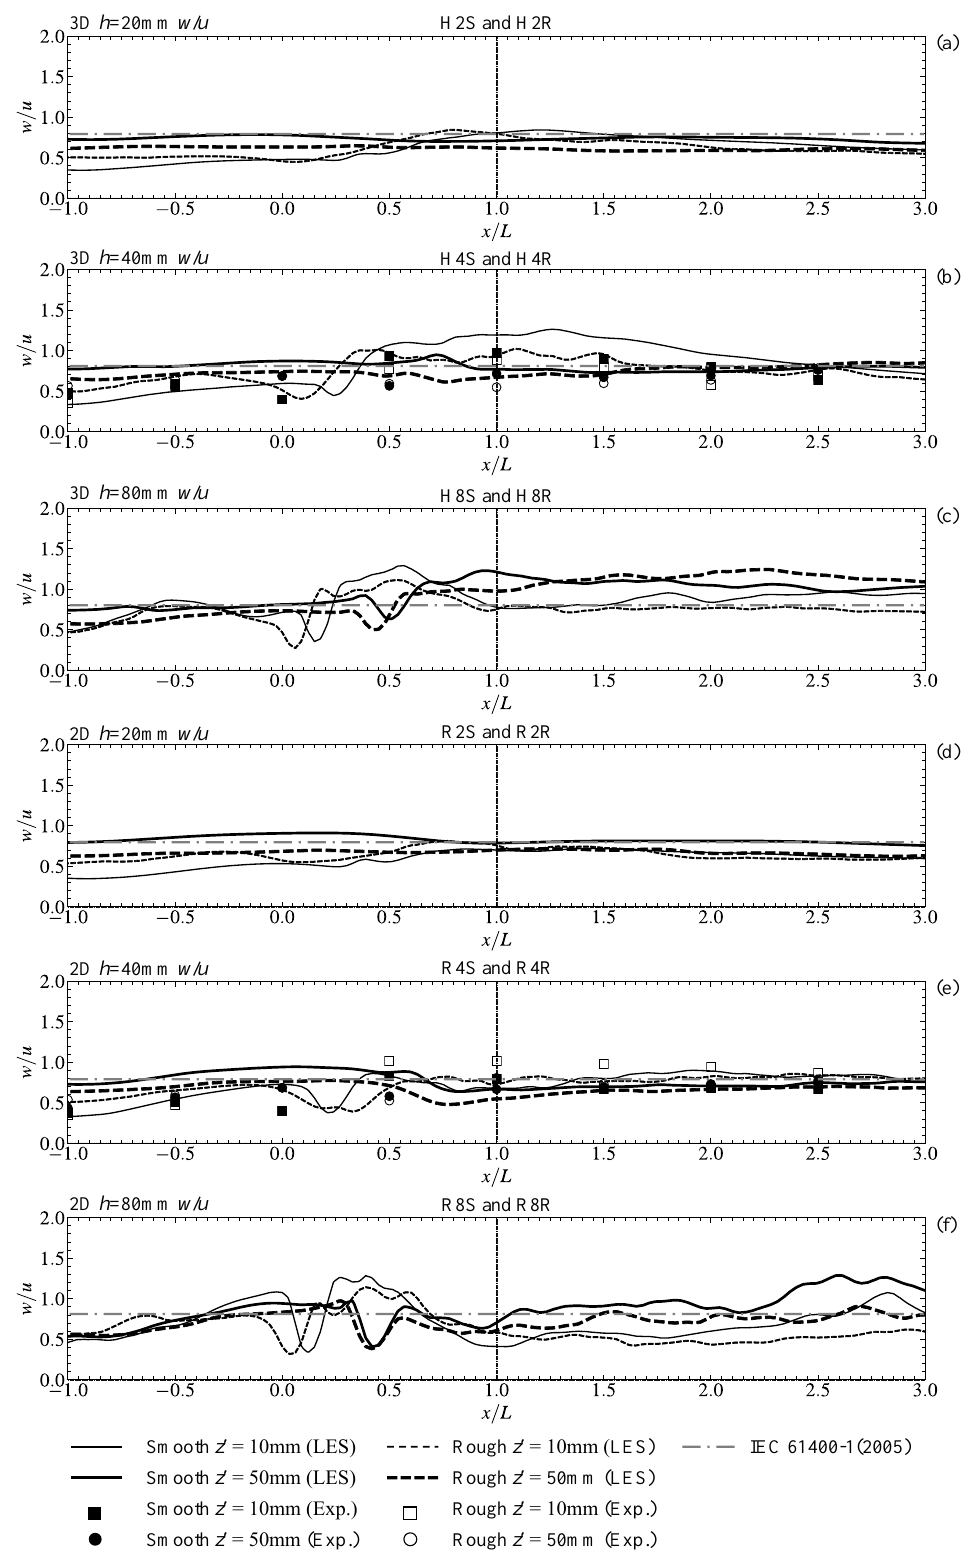
Figure 11. Fluctuation ratio w / u at z ′ = 10 mm and 50 mm, ( a ) 3D hills with h = 20 mm, ( b ) 3D hills with h = 40 mm, ( c ) 3D hills with h = 80 mm, ( d ) 2D hills with h = 20 mm, ( e ) 2D hills with h = 40 mm, and ( f ) 2D hills with h = 80 mm.